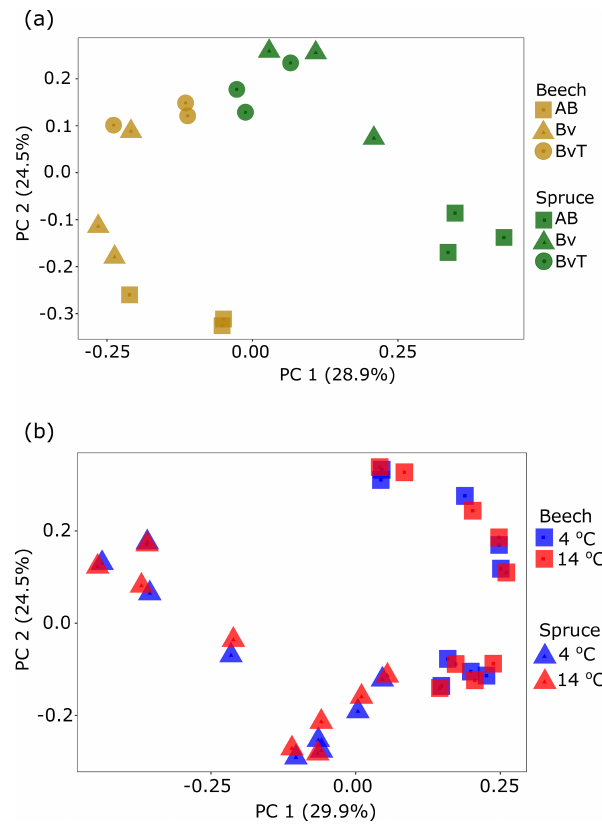
Figure 5. Bacterial community composition and community struc- ture from beech and spruce bulk soil. Shown are the bacterial com- munity structure of (a) the beech (yellow symbols) and spruce (green symbols) bulk soils before incubation and of (b) beech and spruce soils incubated with 2% 13 CO 2 at 4 (blue symbols) and 14 ◦ C (red symbols). PCoA plots are based on OTU level analysis (Bray–Curtis dissimilarity) of 16S rRNA gene amplicons generated by Illumina MiSeq sequencing with three independent data points per depth obtained from beech and spruce